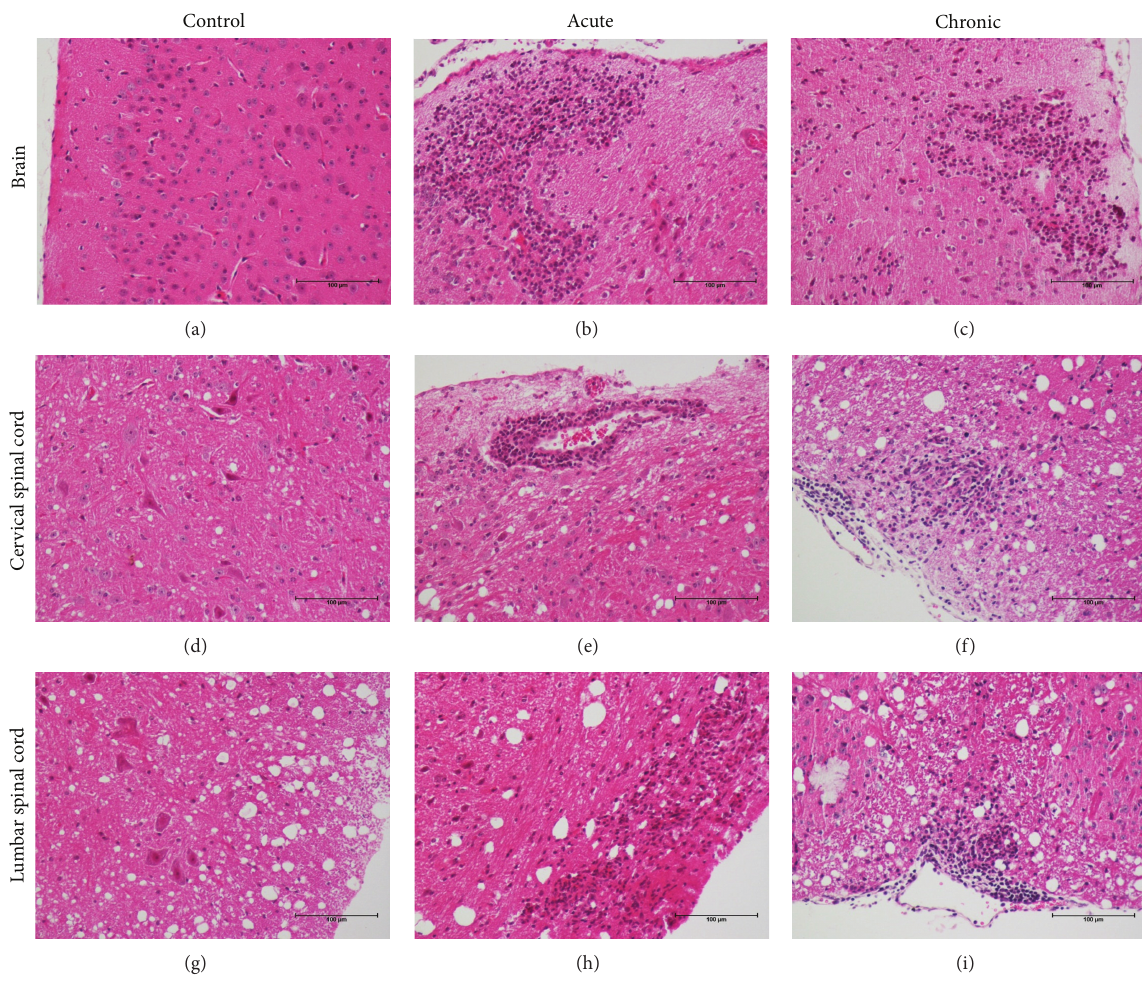
Figure 2: Histopathological analysis of the CNS in C57BL/6 mice with EAE. Female mice were submitted to EAE induction by immunization with MOG emulsified in CFA. Inflammatory infiltrates were evaluated in brain (a, b, and c), cervical (d, e, and f), and lumbar (g, h, and i) spinal cord sections stained with H&E in control animals (a, d, and g) and in animals with EAE during acute (b, e, and h) and chronic disease stages (c, f, and i). Panel is representative of 6